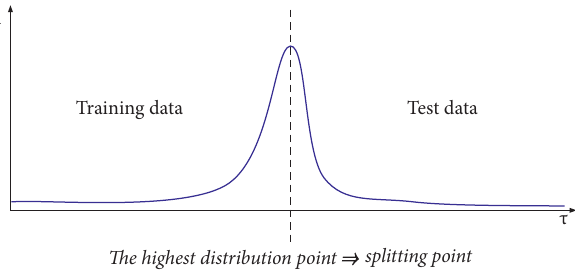
Figure 6: The distribution ( μ ) of origin nodes containing a timestamp ( τ ) in their local interactive event sequences. Source: own elaboration.